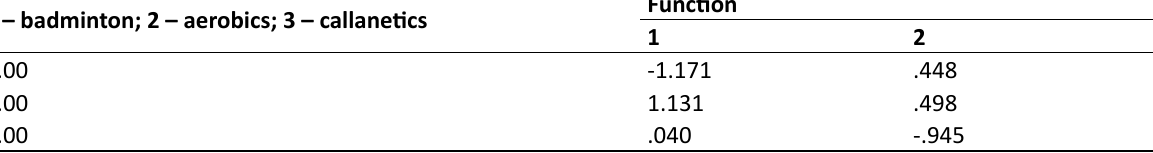
Table 12. Functions at Group Centroids